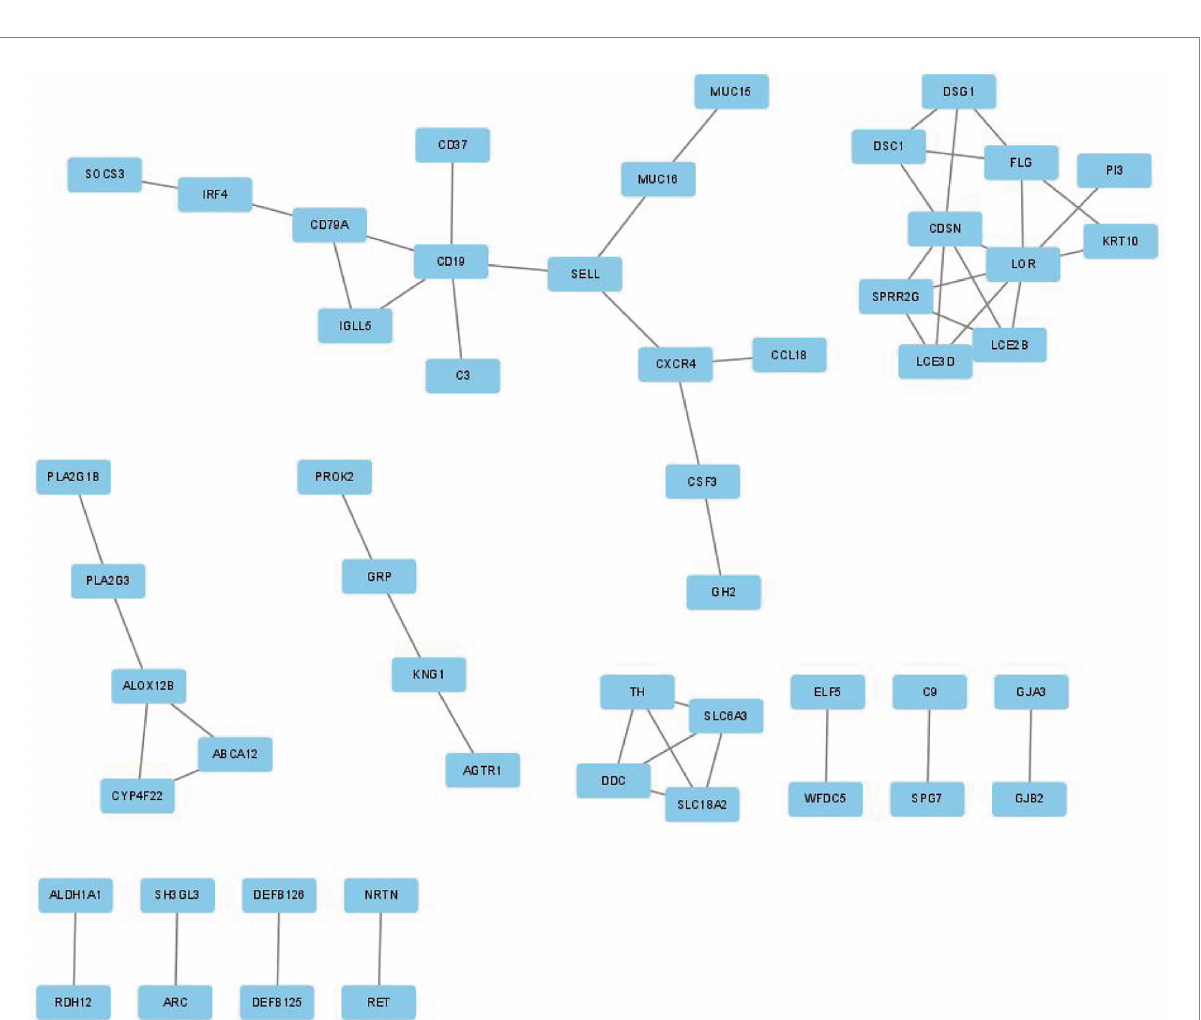
FIGURE 4 PPI network of DEGs in GSE23586 and GSE7621 dataset. PPI, protein–protein interaction; DEGs, differentially expressed